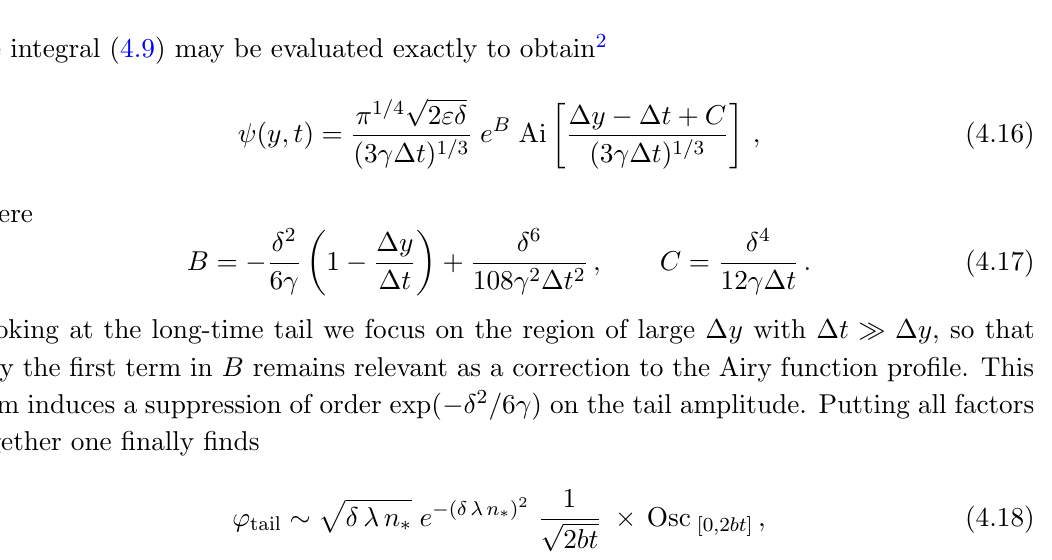
Figure 4 . The amplitude (4.16) for a very narrow initial pulse, (cid:14) = 10 (cid:0) 2 in units of the Lyapunov exponent, is very similar to the amplitude for an initial delta-function